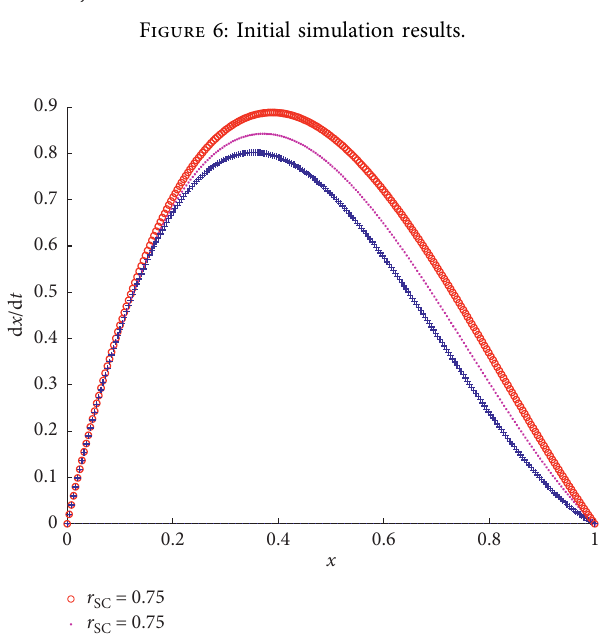
Figure 6: Initial simulation results.